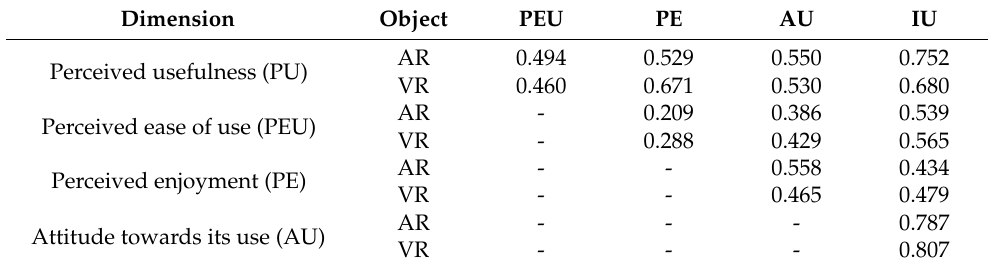
Table 4. Correlations between the different TAM dimensions. Source: developed by the authors. Dimension Object PEU PE AU IU AR Perceived usefulness (PU) Perceived ease of use (PEU) Perceived enjoyment (PE) Attitude towards its use (AU)